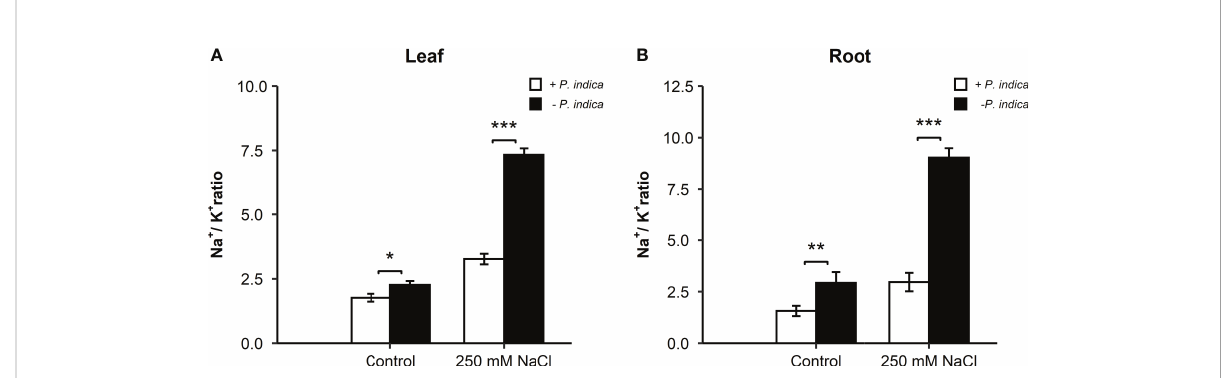
FIGURE 3 Effect of P. indica inoculation on the Na + /K + ratio in date palm seedlings under control and salt stress conditions. (A) Leaf Na + /K + ratio of P. indica colonized and non-colonized date palm seedlings. (B) Root Na + /K + ratio of P. indica colonized and non-colonized date palm seedlings. The values are the means ± SD (n = 3), analyzed by Student ’ s t- test, *p < 0.05, **p < 0.01, and ***p <